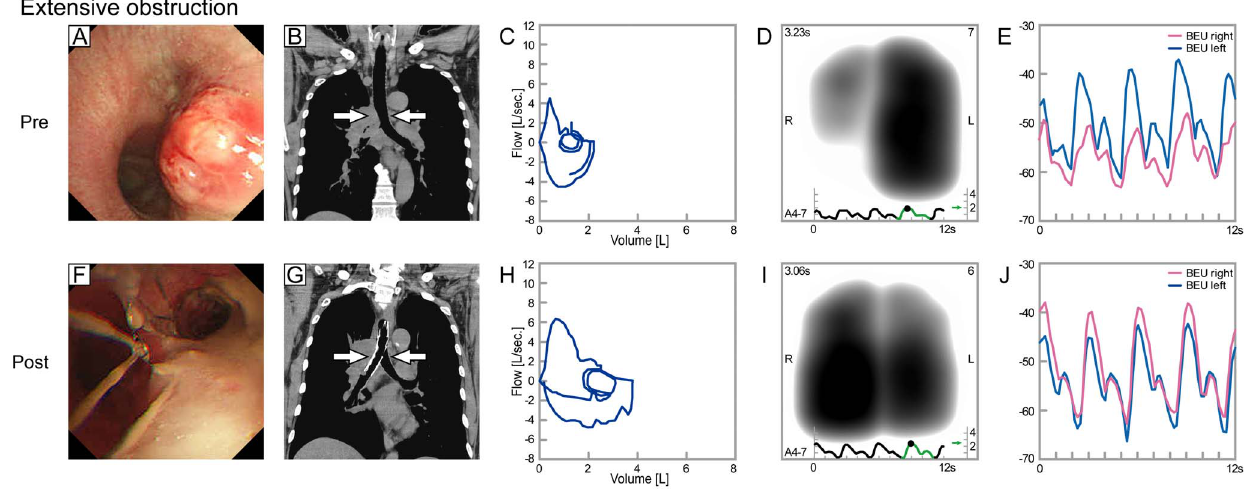
Figure 3. Bronchoscopic and CT findings, flow-volume loops and lung sound recordings for extensive obstruction (before, A–E; after, F–J). This figure shows data of a patient with lung adenocarcinoma. The tumor protrudes from the right side of the trachea and obstructs the right main stem bronchus. The development of lung sound intensity in the right lung, especially the lower lung field, was weaker and lagged behind the left lung (right, red; left, blue). After intervention, these asynchronies were mostly resolved. doi:10.1371/journal.pone.0105327.g003 PLOS ONE |